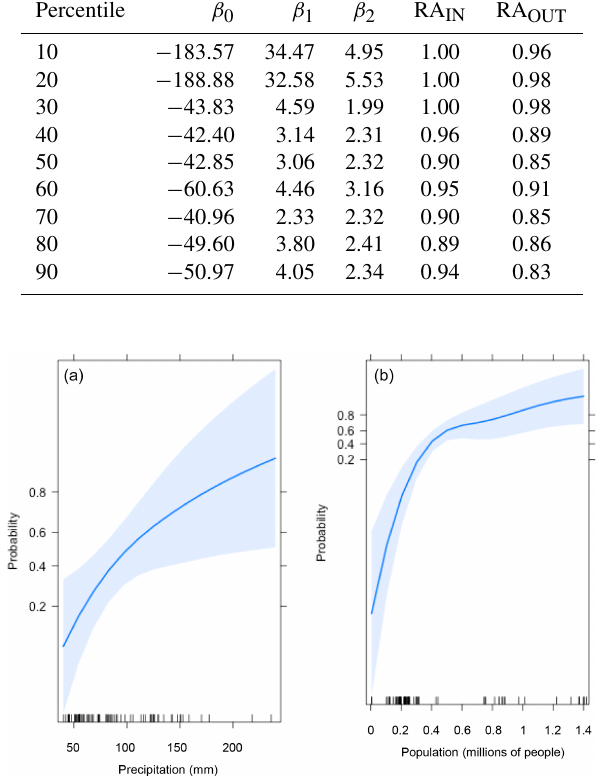
Figure 5. Effect of the explanatory variables ( a : mean precipitation recorded in 24h; b : total population of the basin) on the probability of exceeding the 70th percentile of damage in the Valencian Com- munity. The solid line indicates the best estimate, while the shaded blue bands indicate the 95% confidence interval. The black marks at the bottom of each graph represent the values of the independent variable for each flood